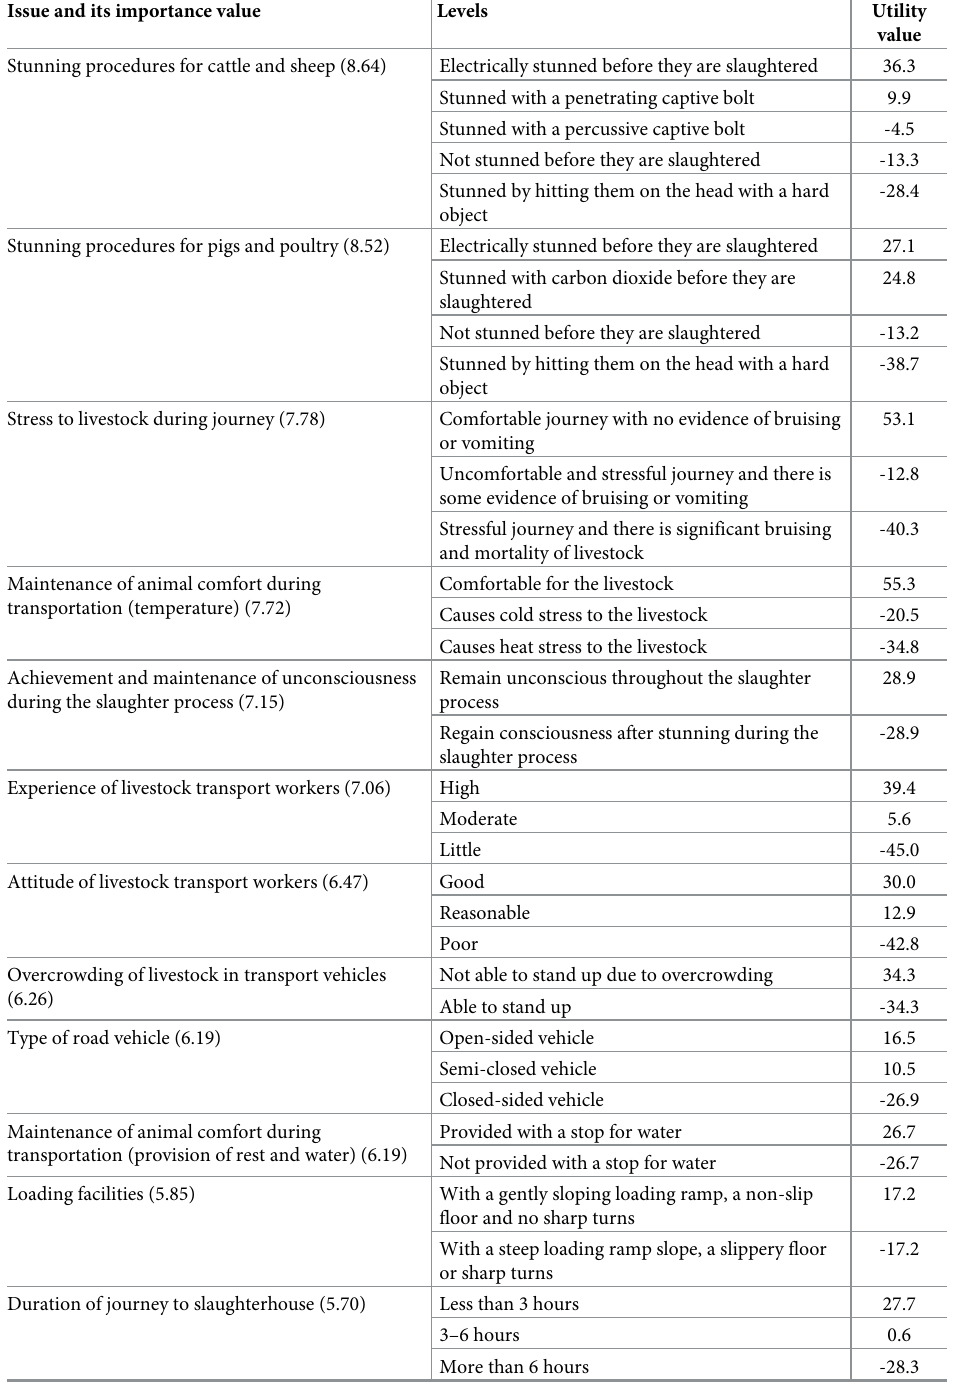
Table 1. Welfare issues and their utility components, indicating the relative strength of preference for each level of welfare provision on each issue. Each issue had 2–5 utility levels demonstrating the perceived importance for ani- mal welfare. The issues are listed in declining order of importance value (the difference that each issue made to the total of all the utility values for each respondent). The average importance and zero-centred utility values are listed for each issue, as rated by respondents (n = 267), who were stakeholders in the animal transportation and slaughter sectors, to a questionnaire on the major welfare issues in the Chinese livestock transport and slaughter